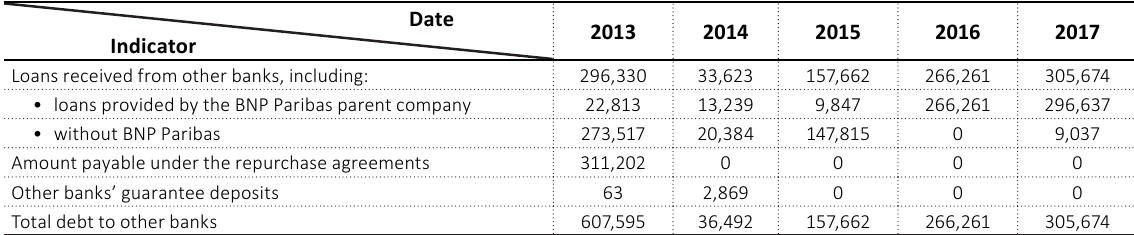
Table 3. Debt of Ukrsibbank to other banks, UAH ths